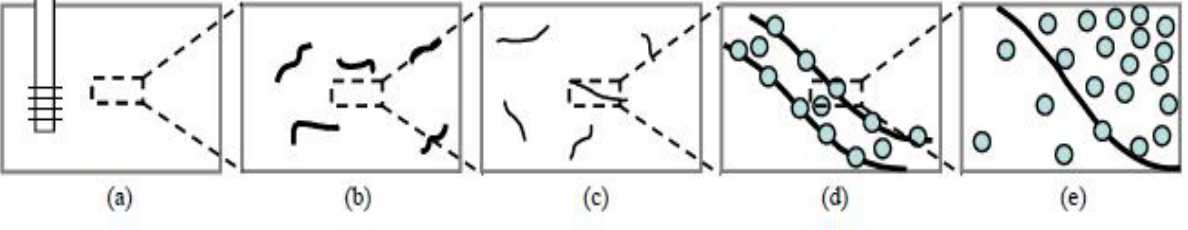
Figure 3—Different length scales for shale gas evolution and production.